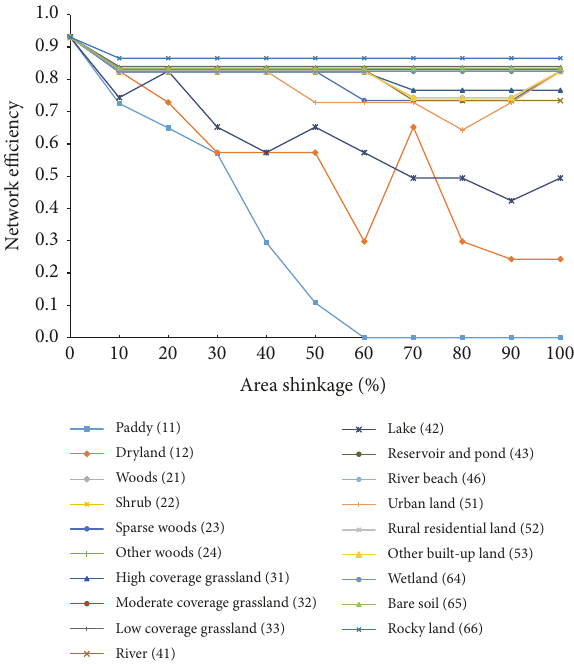
Figure 6: Network efficiency versus different shrinkage in area of each land use type ( 𝛼 =